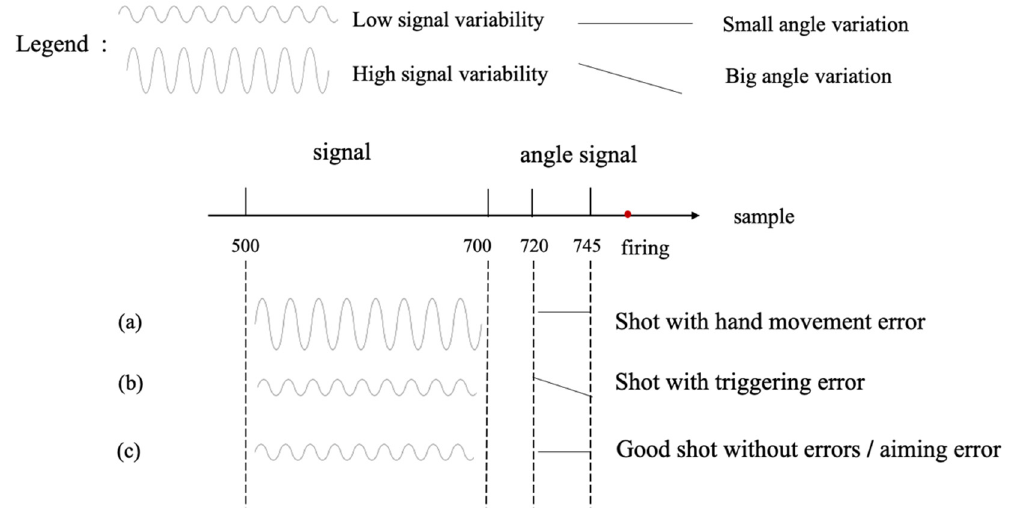
Figure 6. Illustration of the three most common errors in precision shooting: ( a ) hand movement error; ( b ) triggering error; ( c ) aiming error or a good shot.